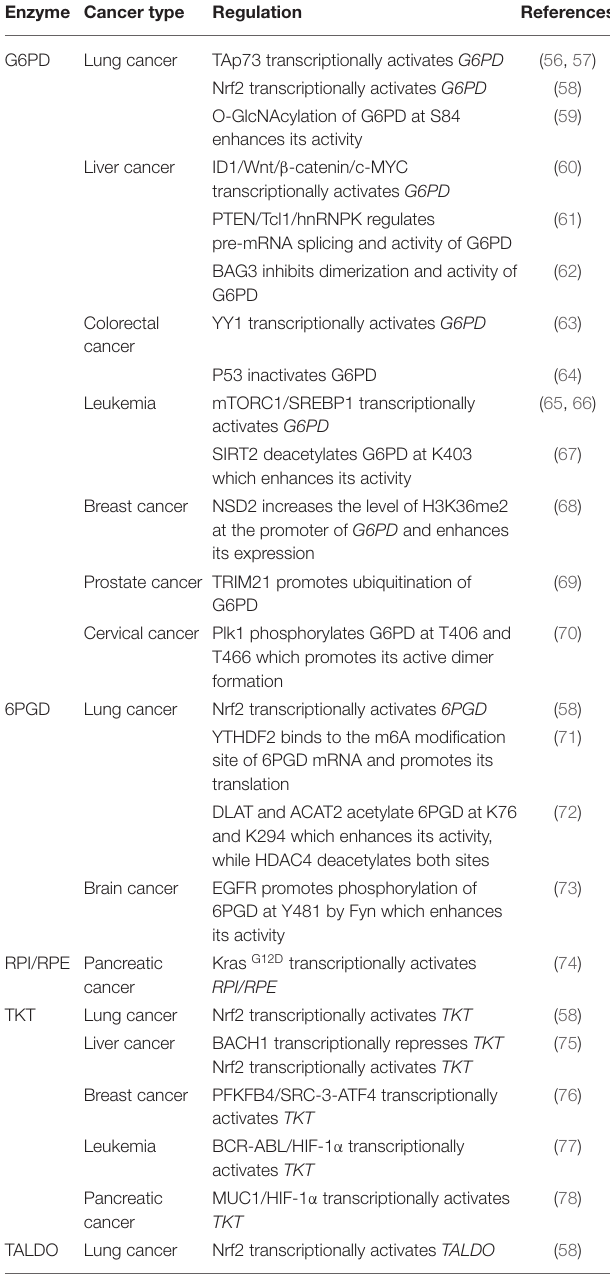
TABLE 1 | The regulation of PPP enzymes in cancer